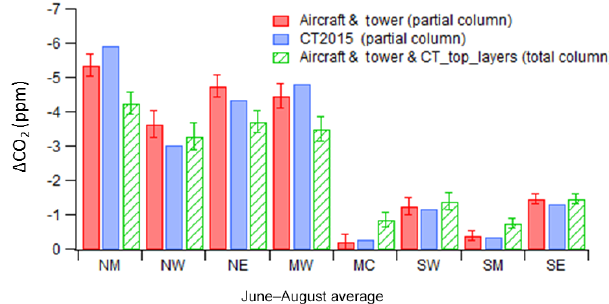
Figure 8. Long-term mean (2004–2014) for June–August partial and total column (cid:49) XCO 2 . The error bars represent 1 standard de- viation from the bootstrap uncertainty calculation (see Sect.